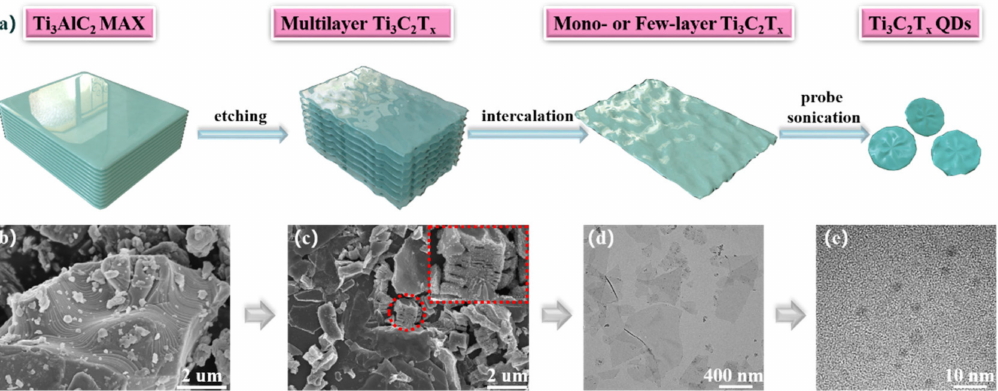
Figure 1. ( a ) Schematic diagram for the preparation of Ti 3 C 2 T x QDs. ( b ) SEM image of Ti 3 AlC 2 MAX. ( c ) SEM image of multilayer Ti 3 C 2 T x NSs. ( d ) TEM image of mono- or few-layer Ti 3 C 2 T x NSs. ( e ) TEM image of Ti 3 C 2 T x